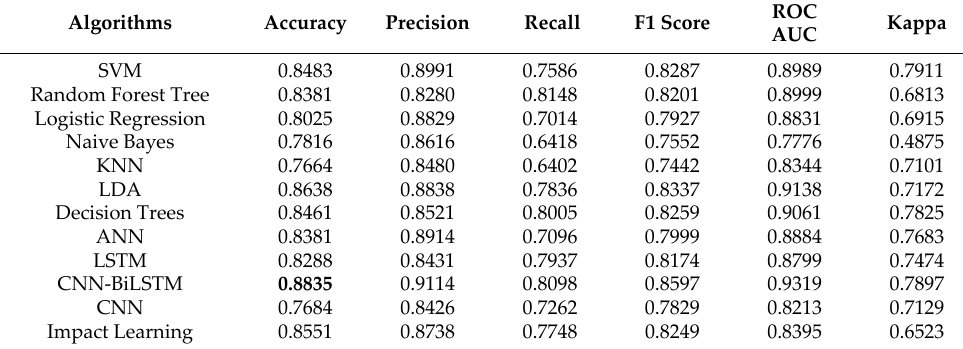
Table 4. Performance of fastText.